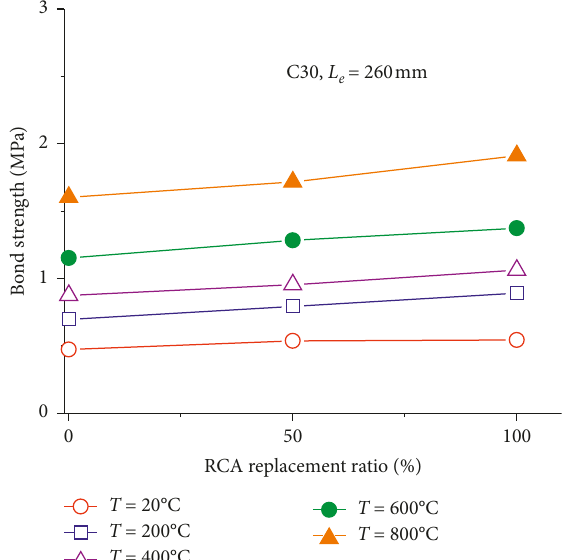
Figure 9: Effect of concrete strength on bond